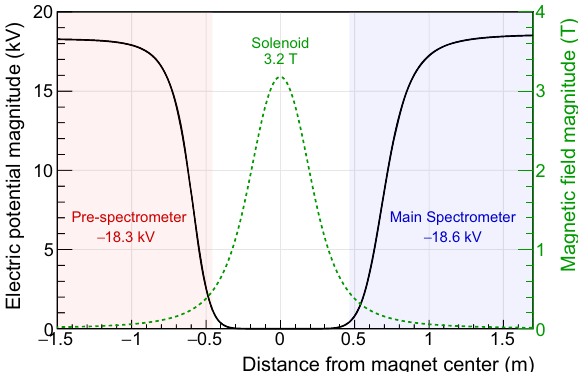
Fig. 2 Distribution of electric and magnetic fields in the region of the inter-spectrometer Penning trap with 71% of the maximum magnetic field of the solenoid. The shaded areas mark different subsystems: pre- spectrometer (red), inter-spectrometer region (white) and main spec- trometer